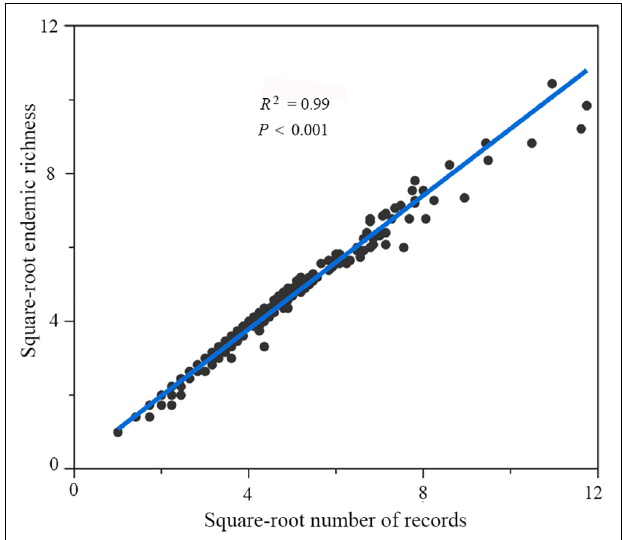
FIGURE 2 | Linear regression ( y = 0.905x + 0.173) for number of records and endemic richness in 1 ◦ grid. The observed richness in the grids below the regression line is > 78.8% of the predicted